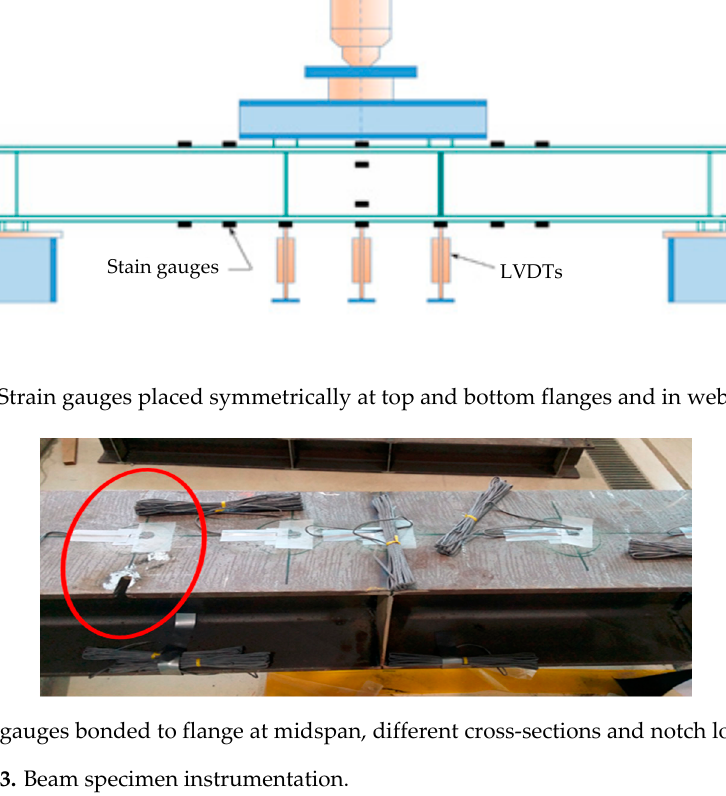
Figure 3. Beam specimen instrumentation.